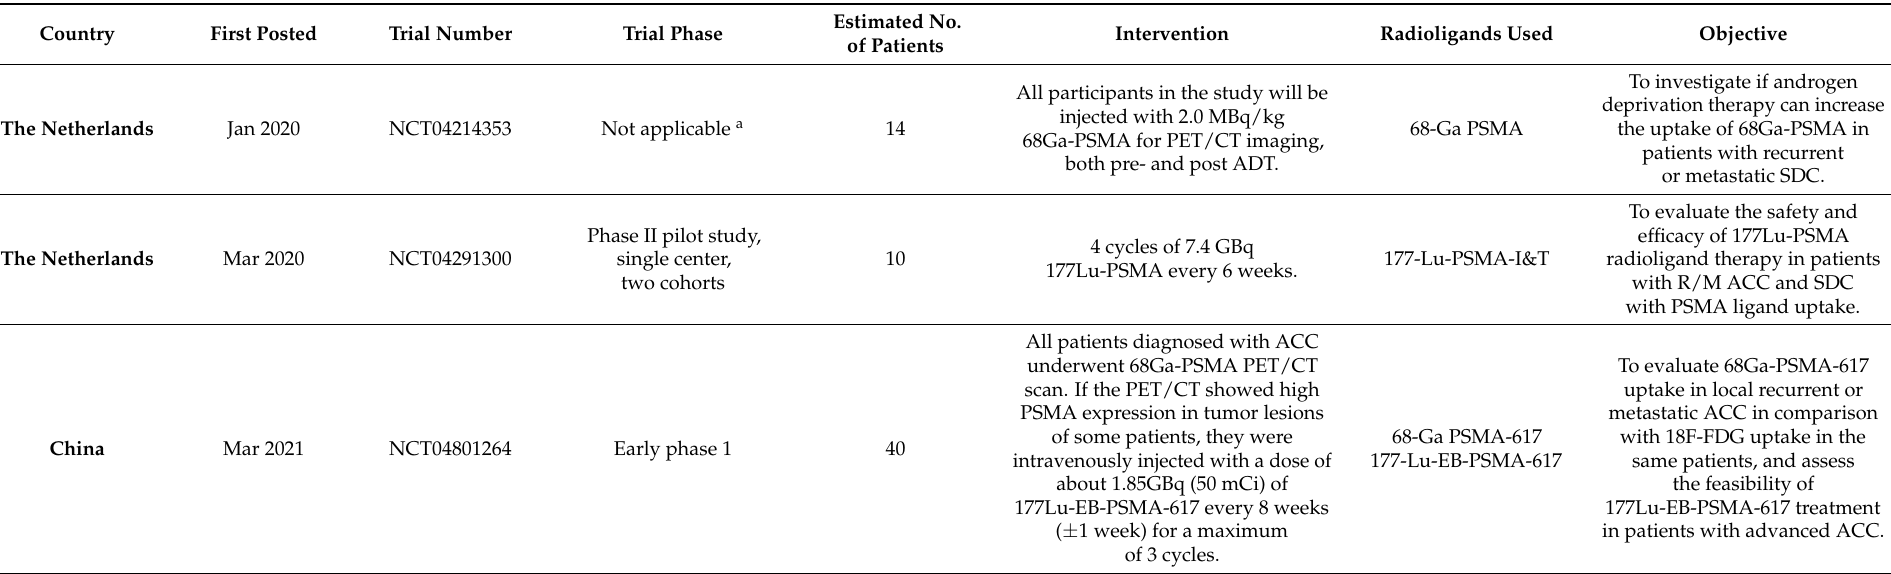
Table 4. Summary of ongoing clinical trials on PSMA PET theranostics in salivary gland